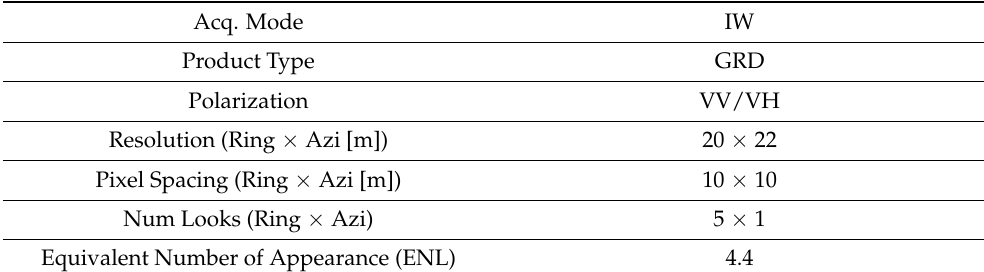
Table 1. The specific parameters of the Sentinel-1 IW GRD level-1 data.